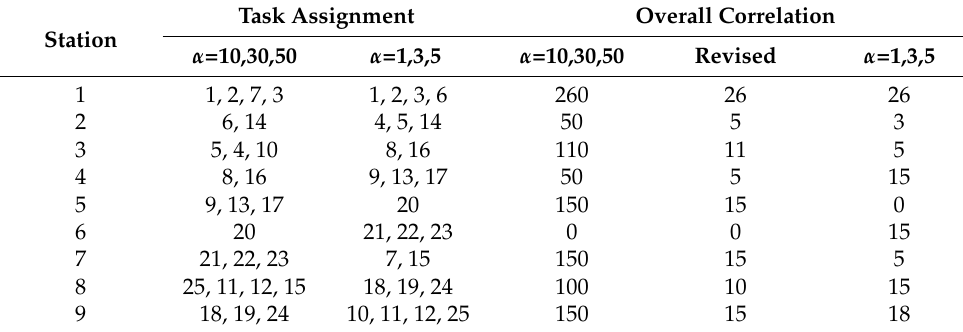
Table 5. Sensitivity analysis considering α = 10,30,50 and α =